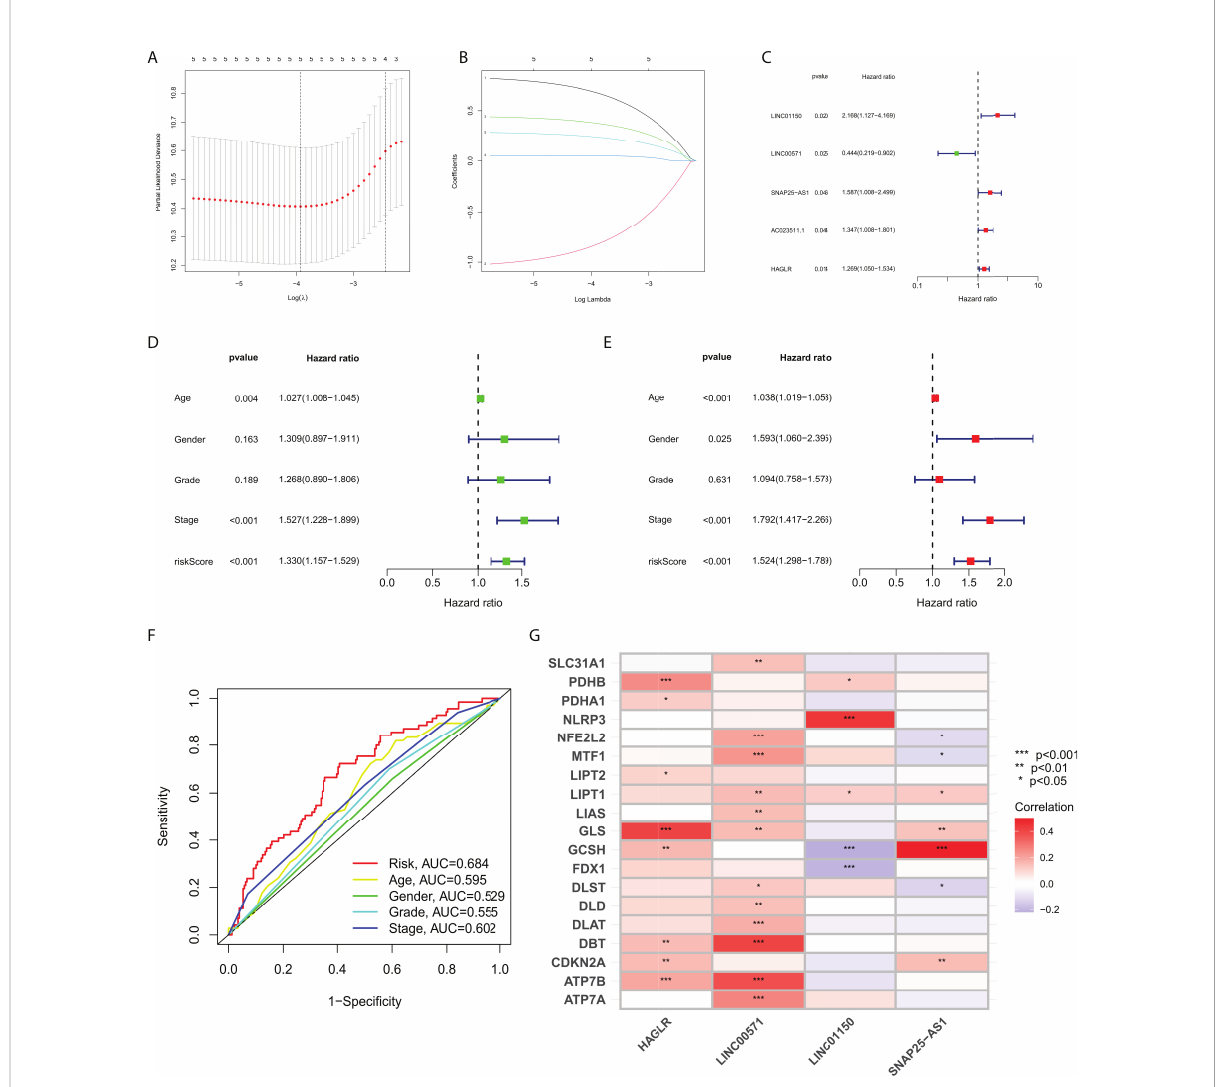
FIGURE 1 (A) LASSO Cox regression analysis revealed fi ve cuproptosis-related lncRNAs based LASSO cross validation plot. (B) LASSO coef fi cient of eight cuproptosis-related lncRNAs in STAD. (C) Univariate Cox regression showed fi ve cuproptosis-related lncRNAs. (D) Univariate Cox regression indicated that the age, and risk score were associated with OS ( p< 0.05). (E) Multivariate Cox regression demonstrated that the age, N-stage, and risk score ( p< 0.001) were independent prognostic indicators of OS in patients with STAD. (F) ROC curve showed that the risk score had